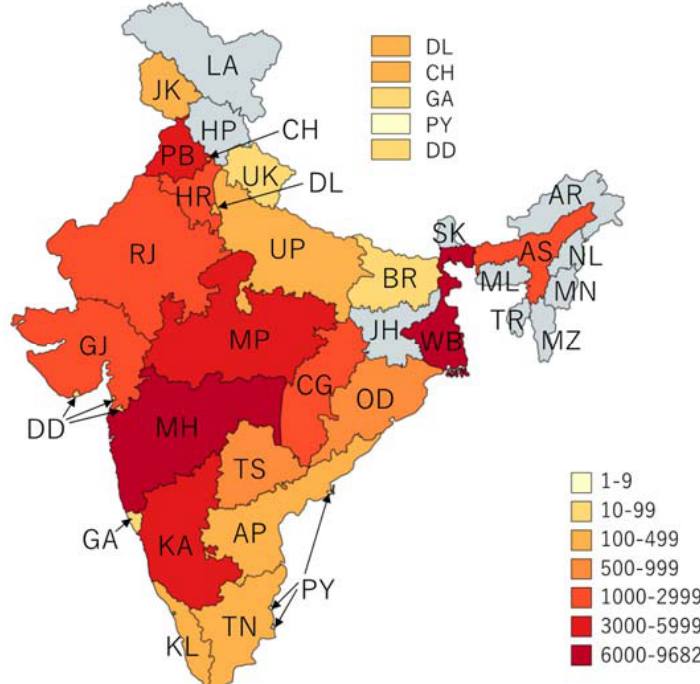
Figure 4. Cholera outbreaks ( n = 565) by year and season, India, 2011–2020. Winter = December to January; Pre-monsoon = March to May; Monsoon = June to September; and Post-monsoon = October to November.